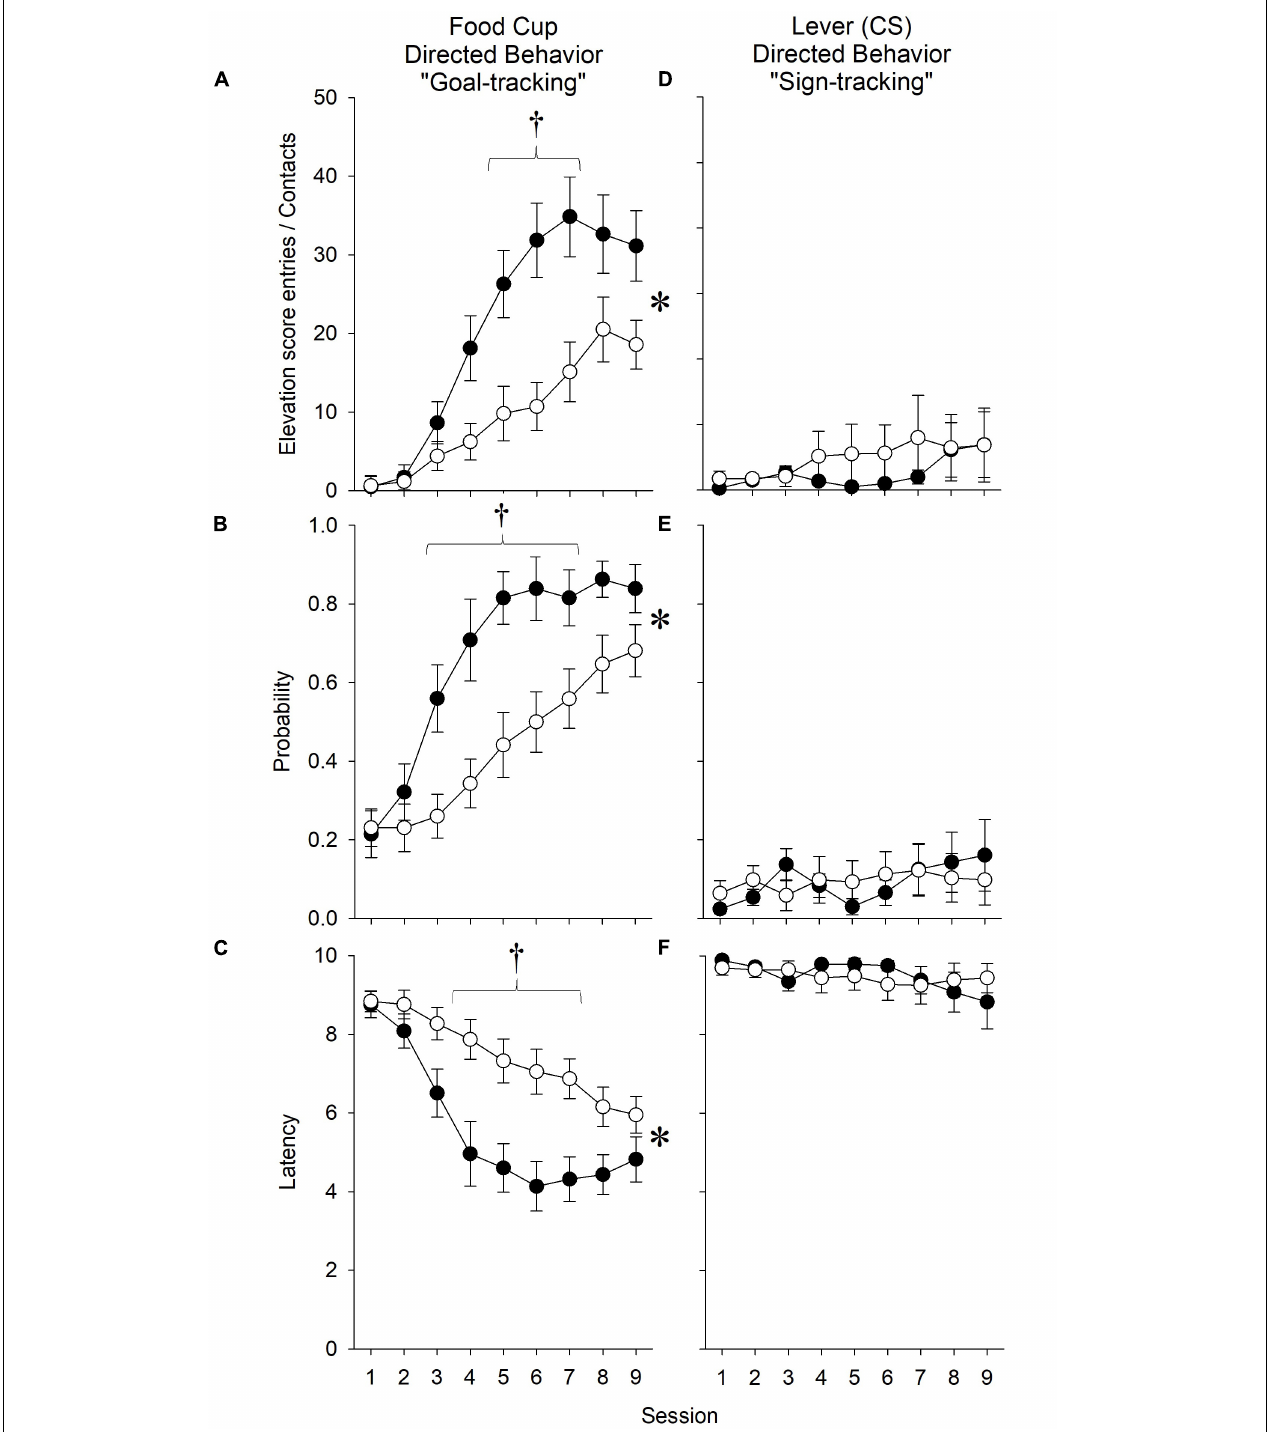
FIGURE 4 | In experiment 1, nicotine enhanced measures of goal-tracking elicited by an ethanol-predictive stimulus relative to saline treatment. During the extension of a lever that predicted the non-contingent receipt of ethanol (15% vol/vol), nicotine (A) increased the number of receptacle entries as calculated by the elevation score, (B) increased the probability of making a receptacle entry, and (C) decreased the latency to the first receptacle entry. Conversely, nicotine did not affect (D) the number of lever presses, (E) the probability of contacting the lever, or (F) the latency to the first lever contact. Asterisk ( ∗ ) indicates significant Treatment × Session interactions, whereas daggers ( † ) indicate significant differences on the indicated test sessions. Data reflect the subjects included in the second ANOVA of experiment 1; thus, rats that did not have an affinity for ethanol are excluded and are collapsed across Ethanol Exposure .